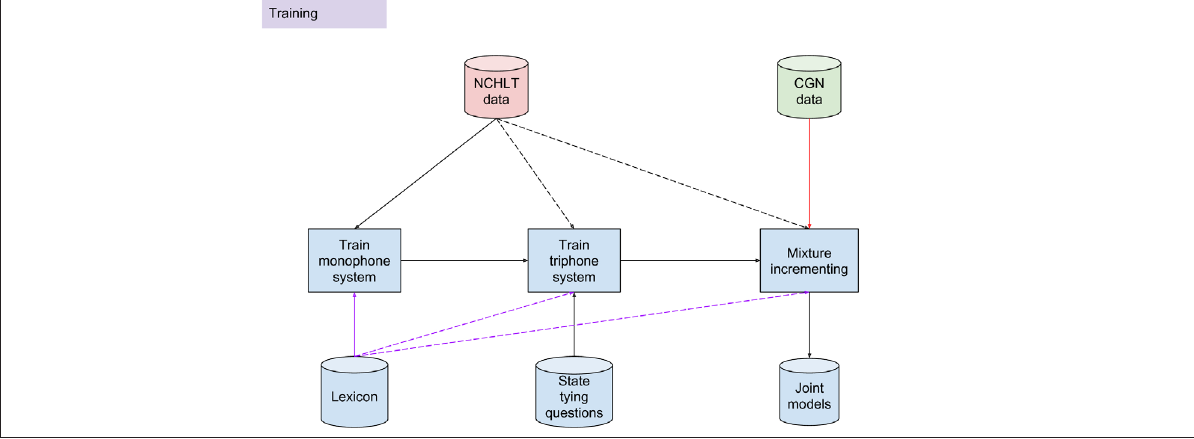
NCHLT, National Centre for Human Language Technology; CGN, Corpus Gesproken Nederlands Figure 5: AutoDac training